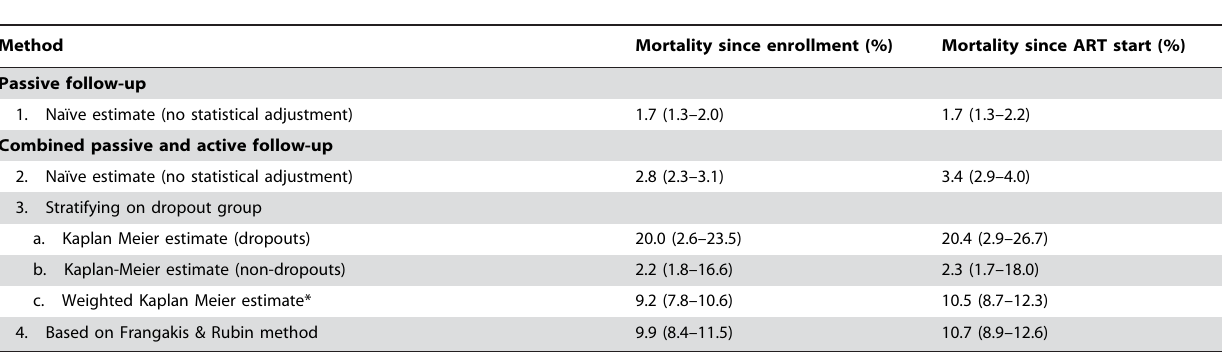
Table 3. Mortality estimates (%, 95% CI) at one year from enrollment and one year from ART initiation. Overall estimates based on entire